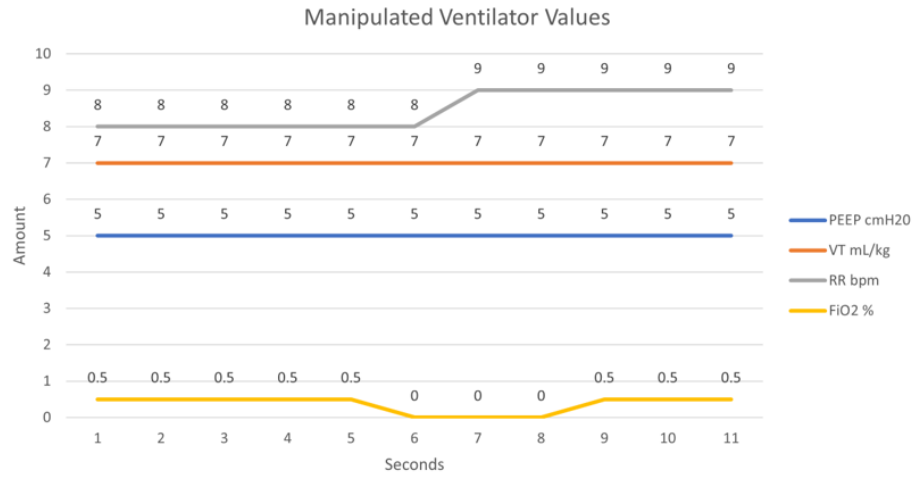
Figure 14. Simulated ventilator parameters under attack scenario.